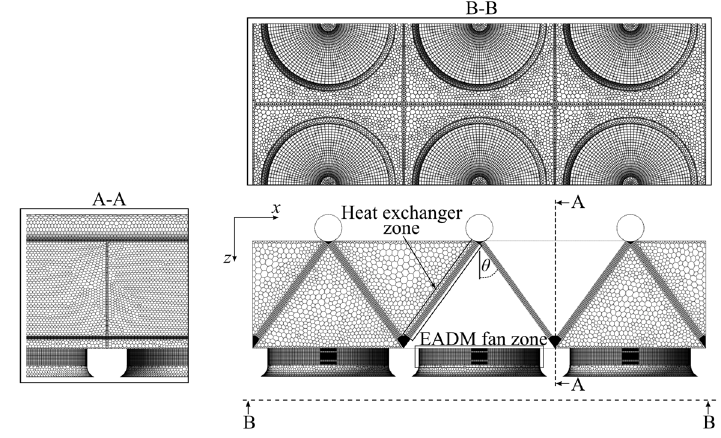
Figure 3. Numerical fan cell configuration and mesh.